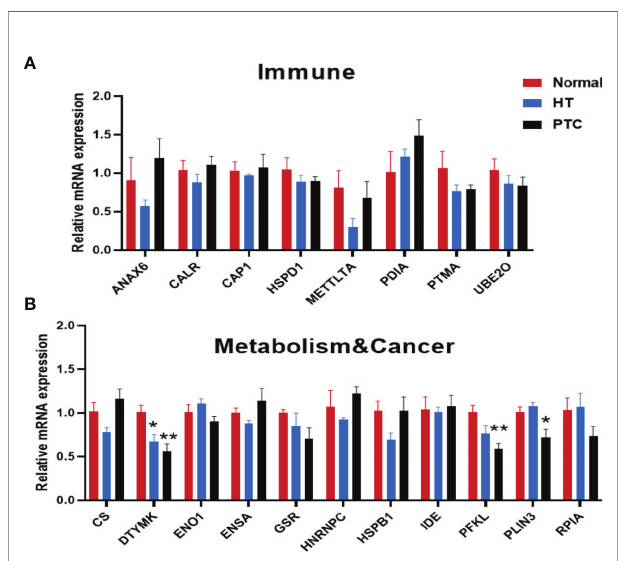
FIGURE 6 | RT-qPCR results of genes relevant to the immune system (A) and metabolism & cancer (B) in thyroid organoids from Normal, HT and PTC. Thyroid organoids were collected 15 days after plating and RNA prepared for RT-qPCR analysis. (Normal, n=5; HT, n=3; PTC, n = 6). Error bars show the mean±SEM. * P <0.05; ** P